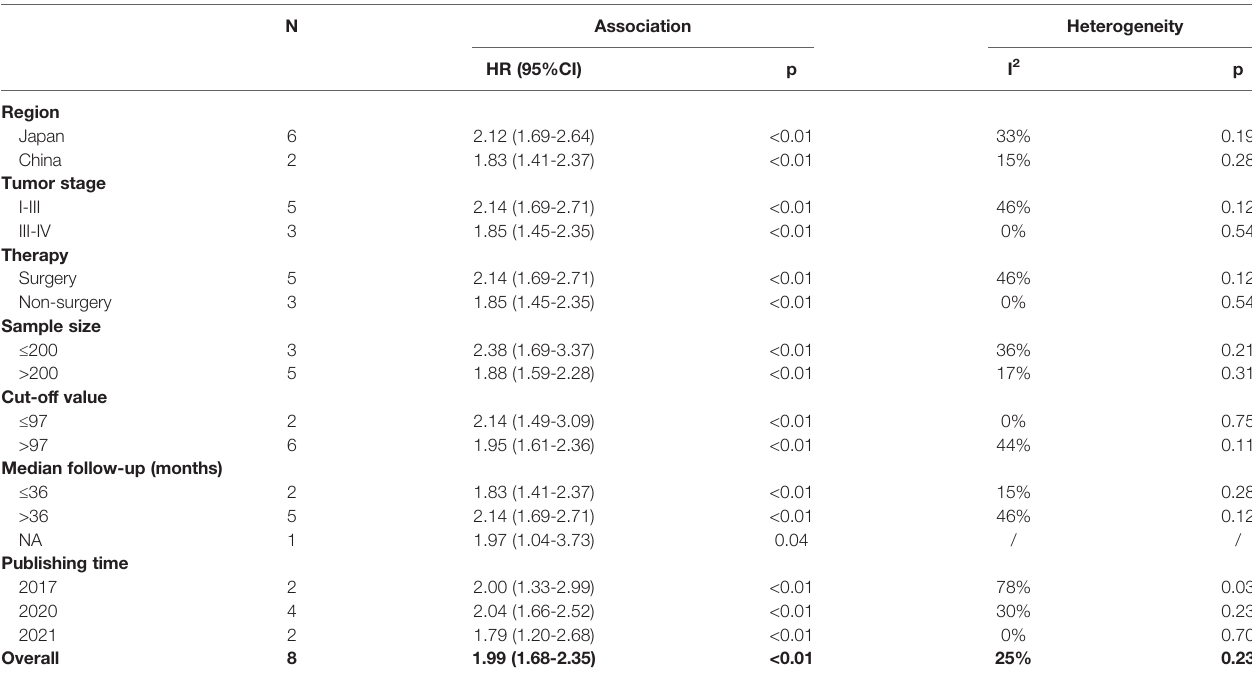
TABLE 2 | Results of subgroup analyses.